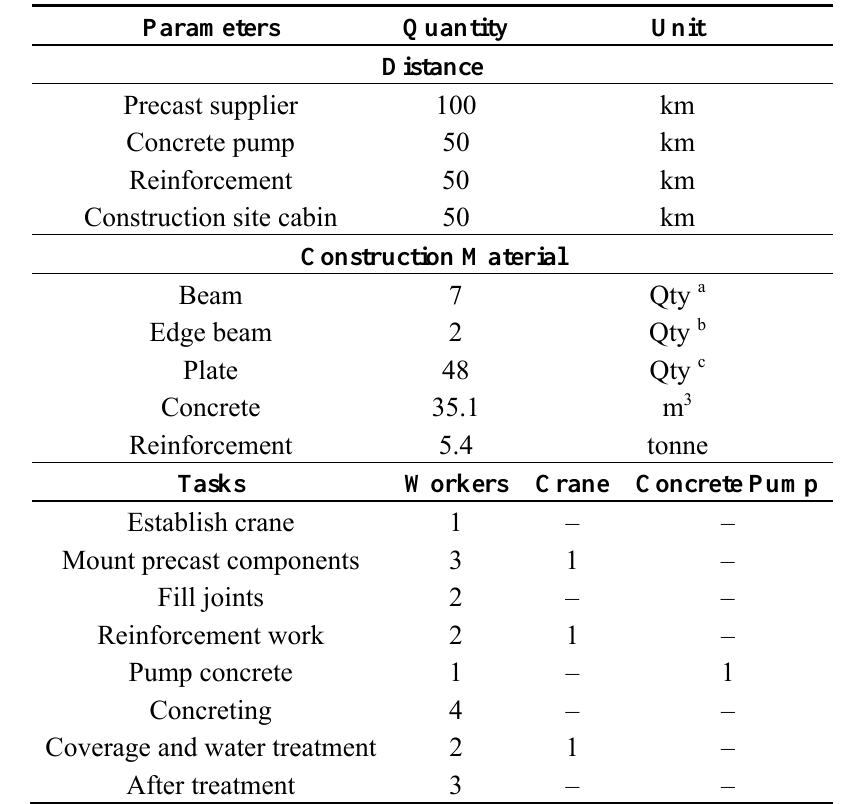
Table 1. Project-specific data of distances, material quantities and